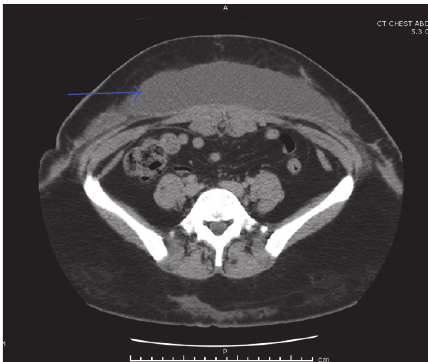
Figure 3: Soft, fluctuant, erythematous, and tender swelling in the lower central back (upper border of the tattoo).